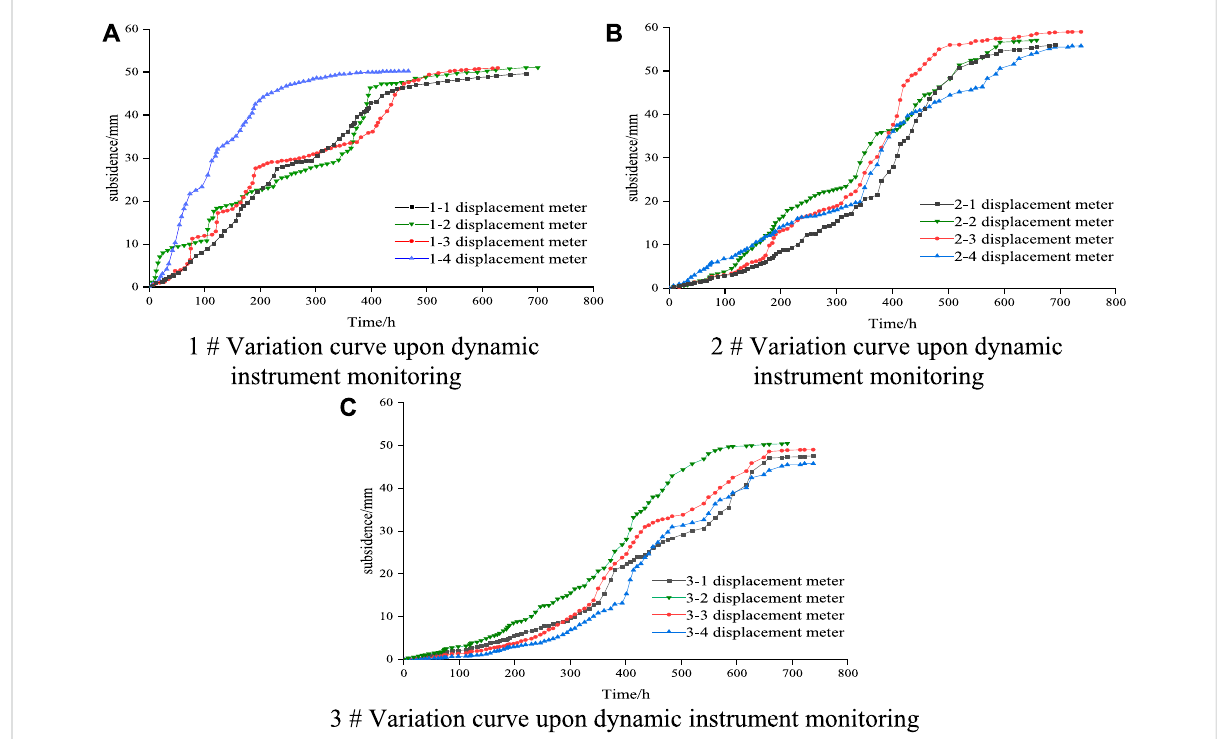
FIGURE 16 Variationcurveupondynamicinstrumentmonitoring, (A) 1#Variationcurveupondynamicinstrumentmonitoring, (B) 2#Variationcurveupon dynamic instrument monitoring, (C) 3 # Variation curve upon dynamic instrument